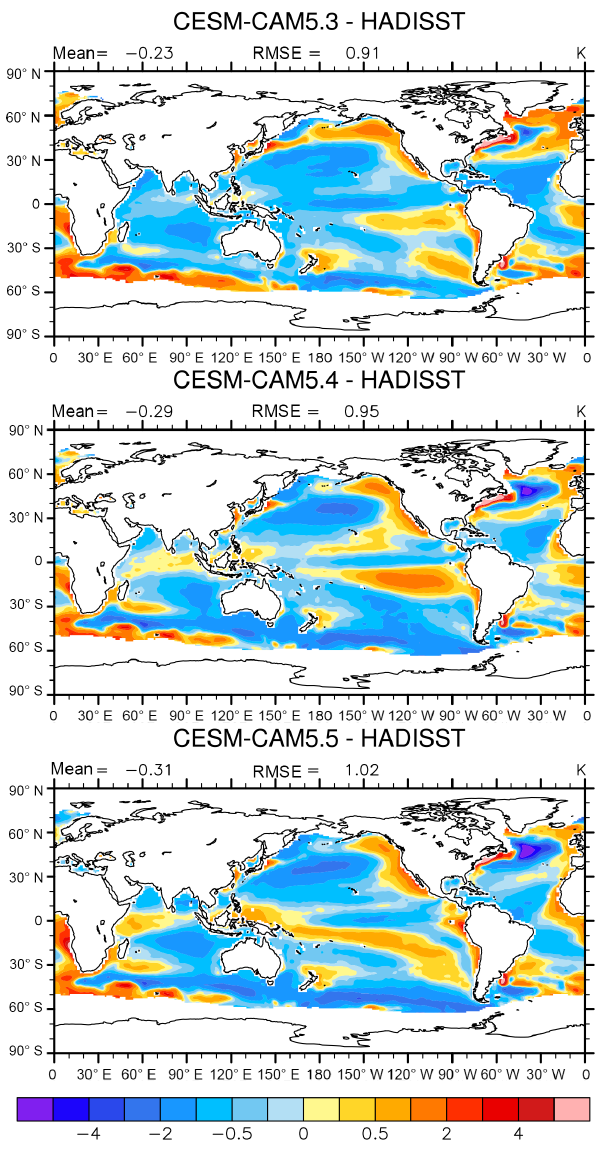
Figure 8. Same as Fig. 2 but for sea surface temperature biases computed relative to pre-industrial HadISST observations.